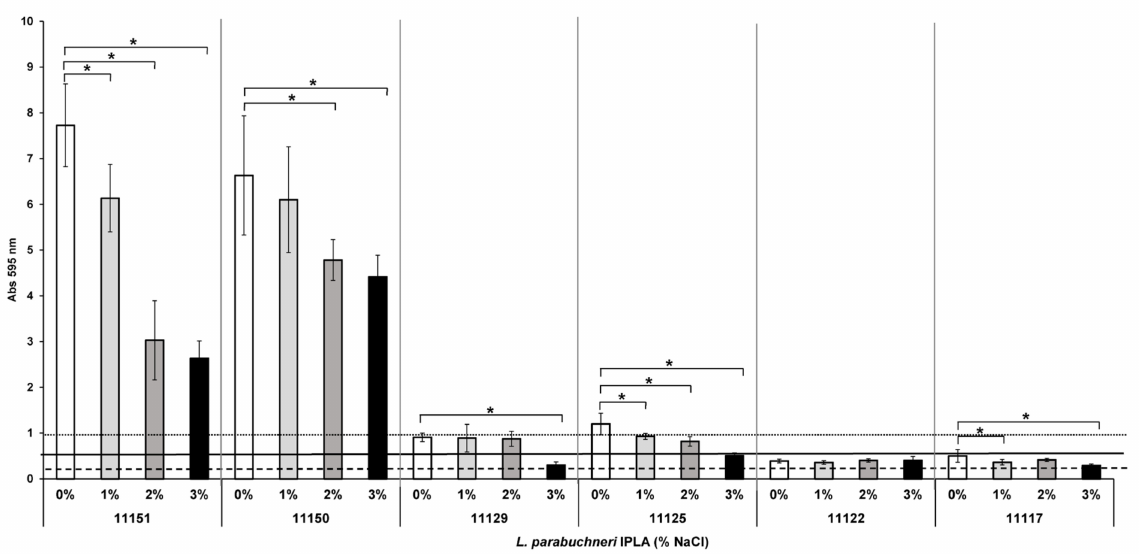
Figure 7. Effect of NaCl concentration (in % p / v ) on biofilm-producing capacity on polystyrene of the histamine-producing L. parabuchneri strains. The strains were incubated for 48 h at 37 ◦ C. Data represent means ± SD (error bars) of three experiments. Values marked with * differ significantly. The producer/nonproducer cut-off (weak producer) is signaled by the dashed line (ODc), the solid line is 2 × ODc (moderate producer) and the dotted line 4 × ODc (strong